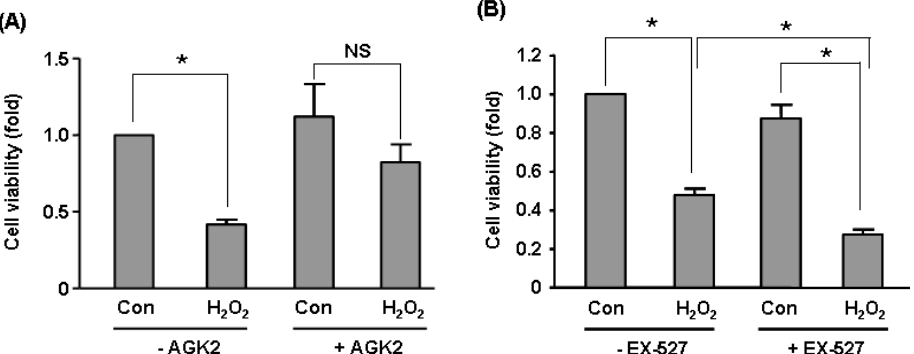
Figure 6. Effects of ( A ) selective Sirt2 inhibitor AGK2 (10 μ M) and ( B ) selective Sirt1 inhibitor EX-527 (10 μ M) on H assay. Cells were treated with H or EX-527 pre-treatment. Data are mean  SEM. * p < 0.05, one-way ANOVA, n = 4–6. NS: